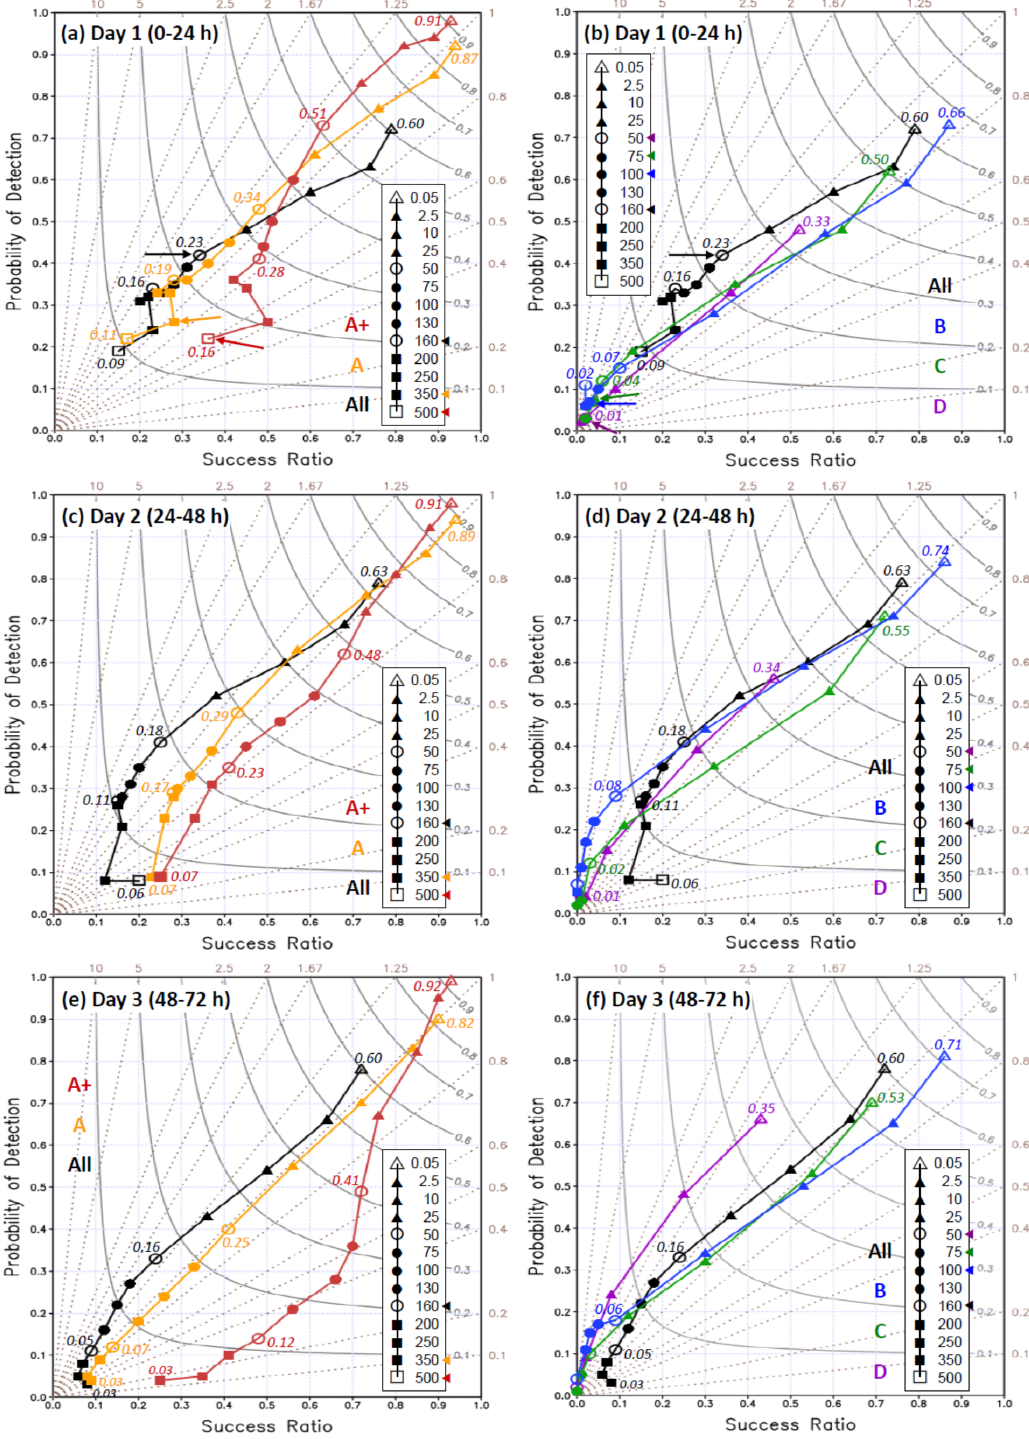
Figure 4. Performance diagrams of 24h QPFs for (a, b) day 1 (0–24h), (c, d) day 2 (24–48h), and (e, f) day 3 (48–72h) by the 2.5km CReSS at 13 rainfall thresholds (inserts) from 0.05 to 500mm during three Mei-yu seasons (May–June) in 2012–2014 in Taiwan. Results for groups A + , A, and “all” (“all”, B, C, and D) are plotted in the left (right) column with different colors. TS values are labeled at fixed thresholds of 0.05, 50, 160, and 500mm (open symbols) or selected endpoints (smaller fonts), and data points with TS = 0 at high thresholds are omitted. For each group, the threshold where the observed rain area size ( O/N ) falls below 1% is labeled in the insert and also marked by an arrow in (a, b)